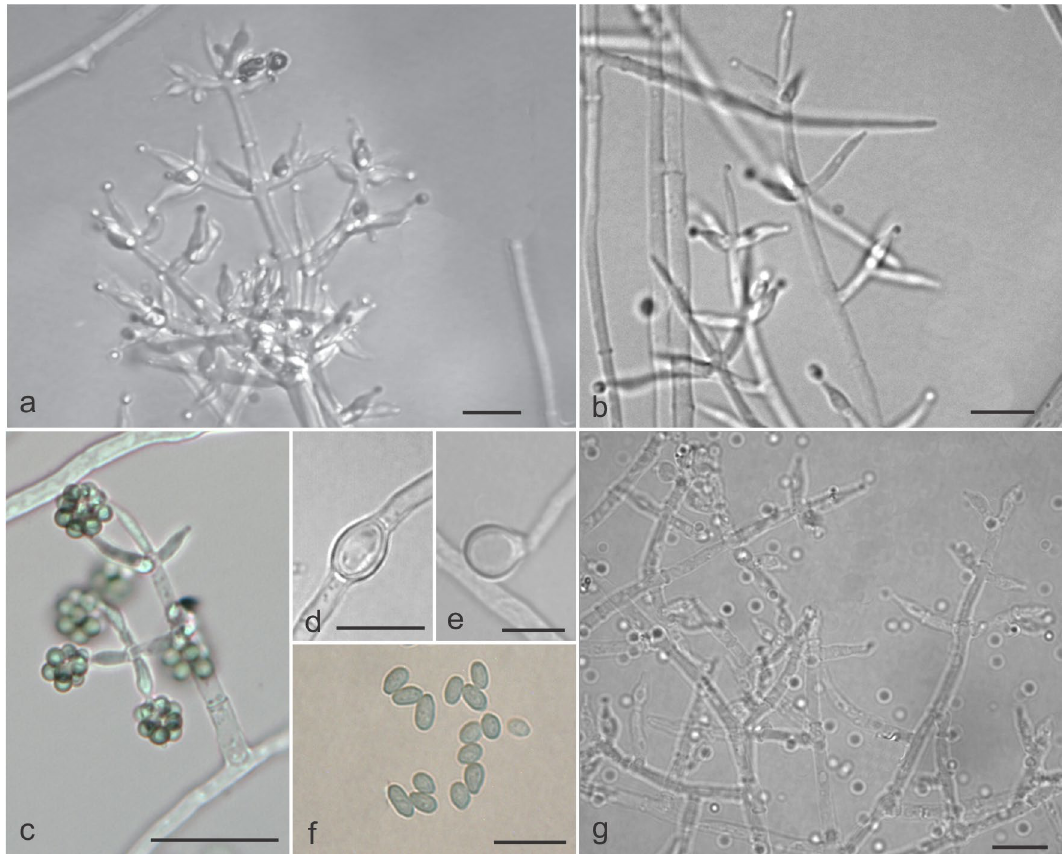
Figure 11. Morphological features characteristic of Trichoderma lentissimum sp. nov. (COAD 2399). ( a – c , g ) Conidiophores and phialides formed on SNA and CMD. ( d , e ) Chlamydospores on CMD. ( f ) Conidia. Bars: ( a , b , d – f ) = 10 µm; ( c , g ) = 20